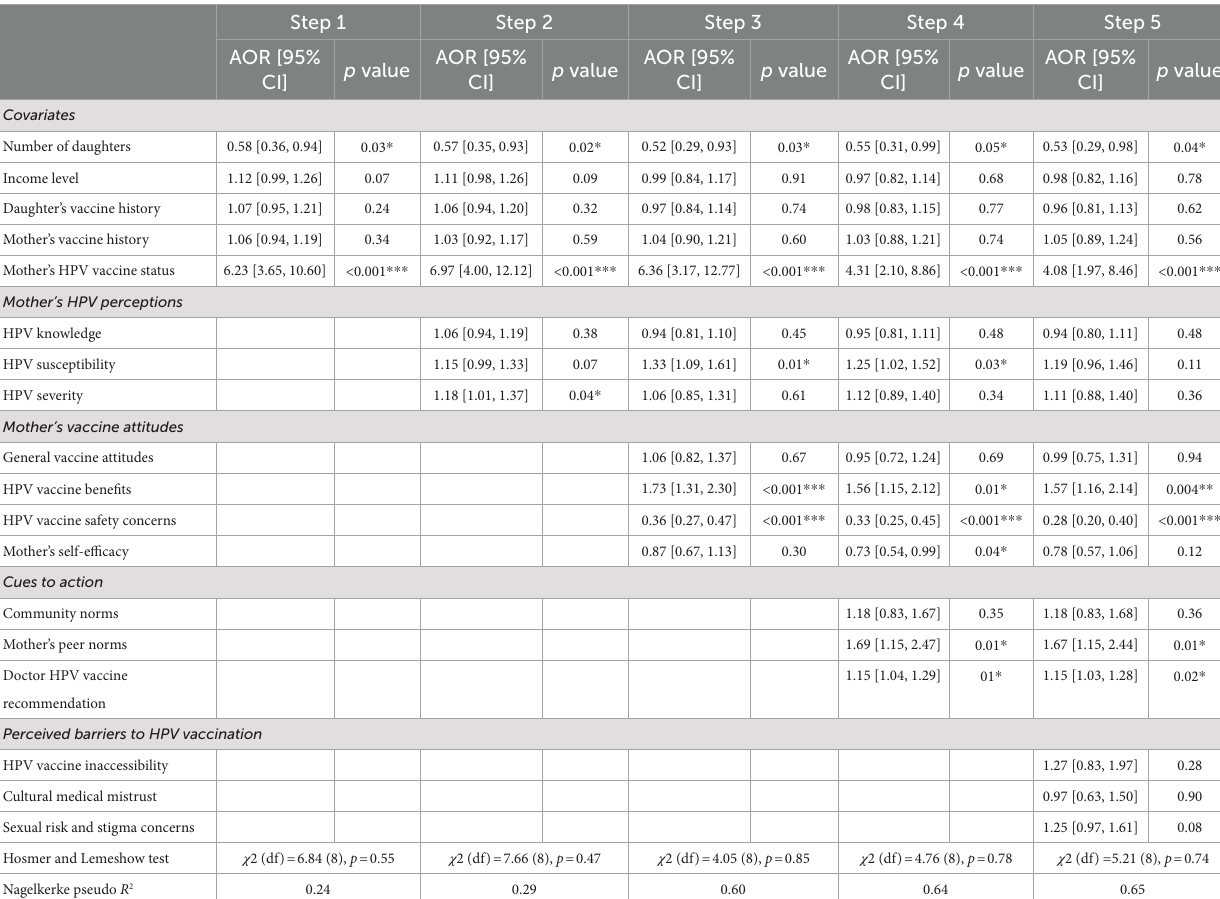
TABLE 4 Multivariable associations between determinants of HPV vaccine intentions and HPV vaccine intentions. Step 1 Step